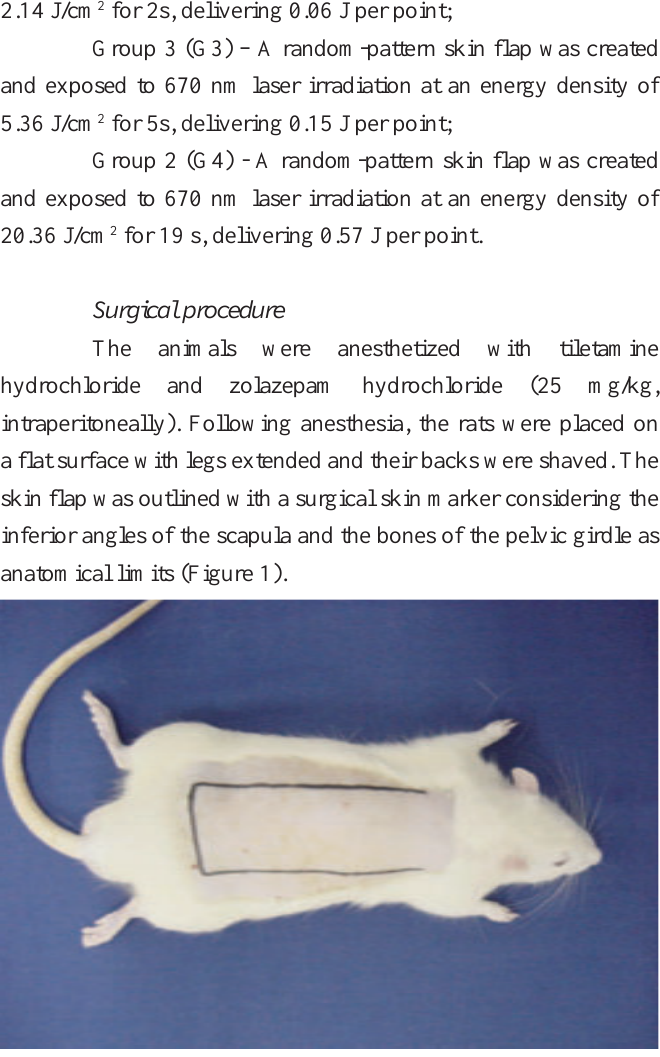
FIGURE 1 - Dorsal view of the animal after shaving, showing the flap